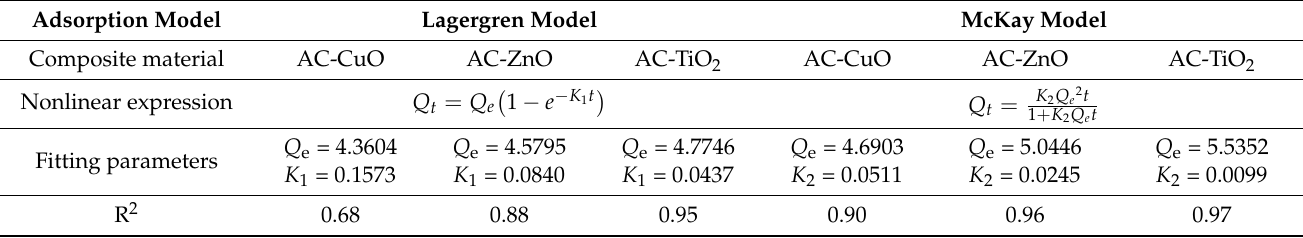
Table 4. Summary of correlation coefficients for kinetic model fitting.